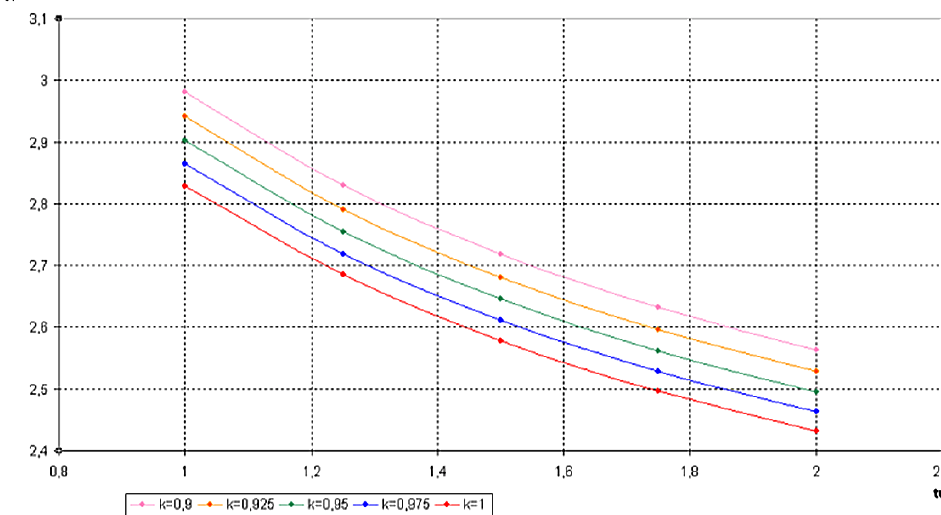
for irreversibility factor k as U